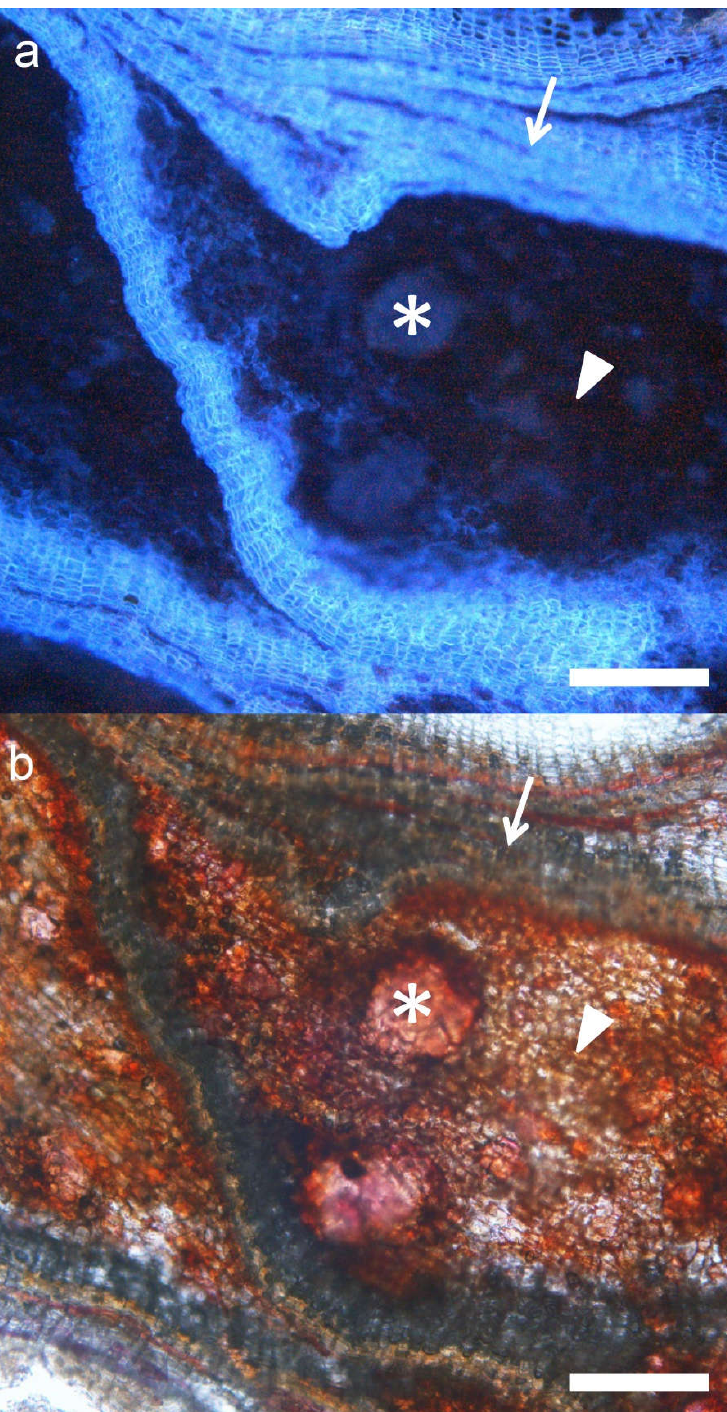
Figure 7. Cross section of the bark of a hybrid tree under UV ( a ) and visible light ( b ). Periderms (arrow), schlerenchymatic nodules (asterisk), and non-suberized inactive phloem (arrowhead) can be appreciated. Bar: 100 μm.